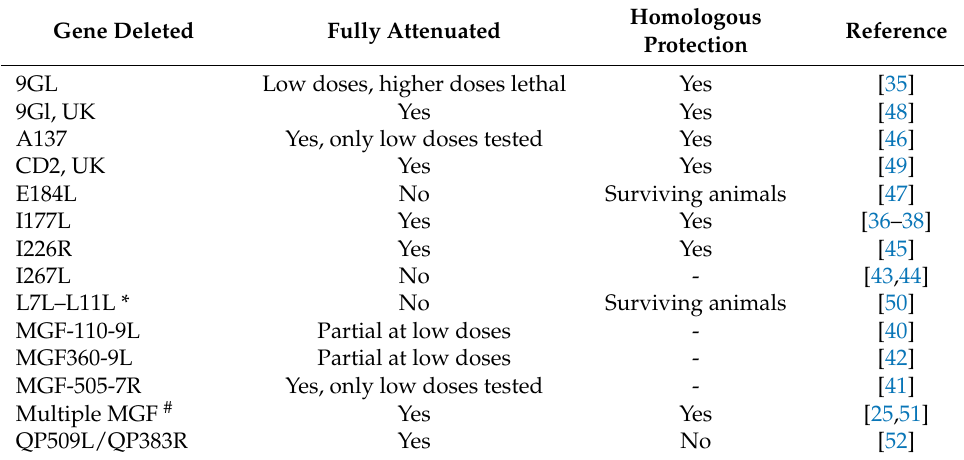
Table 3. Determinants of virulence that attenuate ASFV-Georgia-derived